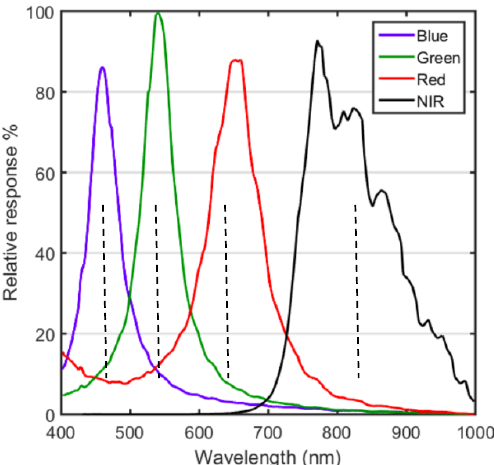
Figure 4. Spectral sensitivities of the used four-band image sensor (manufacturer’s data); dotted lines represent the working wavelengths.